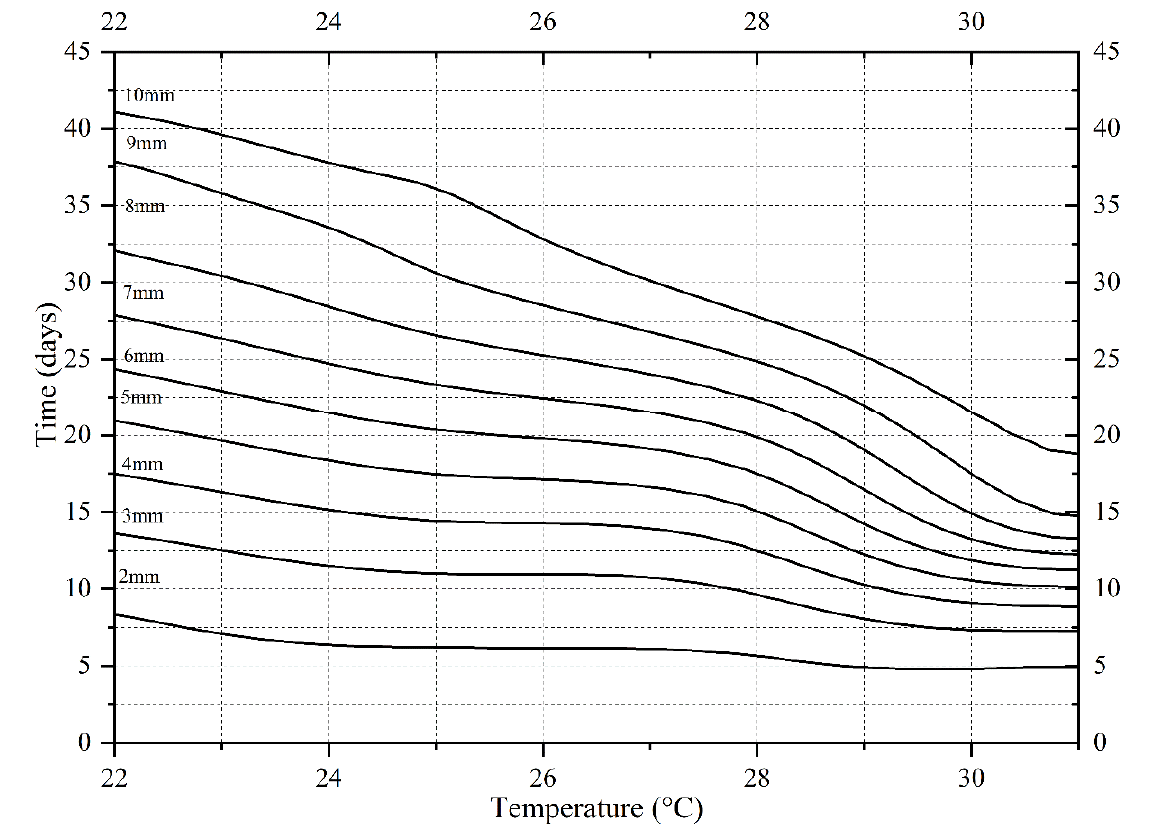
Figure 6. Isomegalen diagram of Necrobia ruficollis. Each contour represents a specific larval body length.